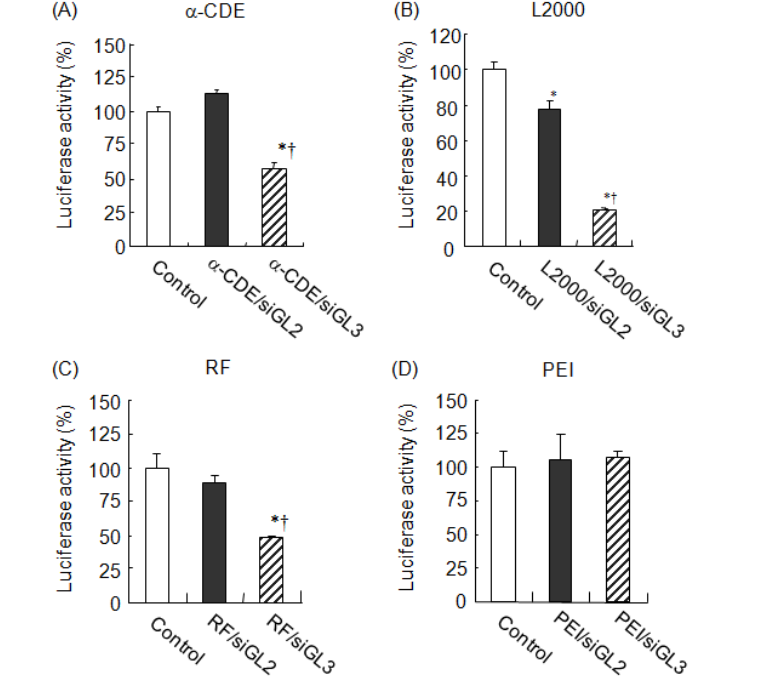
Figure 5. Inhibitory effects of binary complexes of carrirers/siRNA on luciferase activity in cells stably expressing luciferase gene (NIH3T3-luc cells).